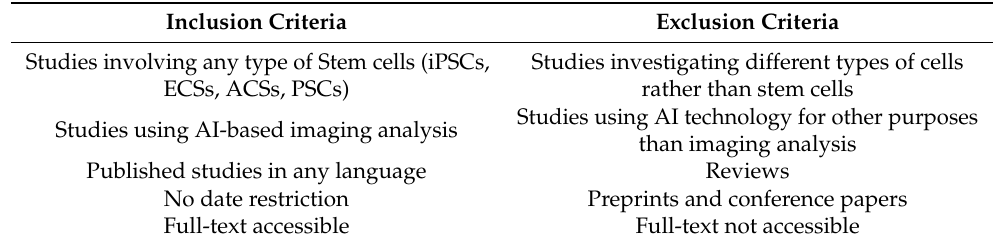
Table 1. Table of Inclusion and Exclusion